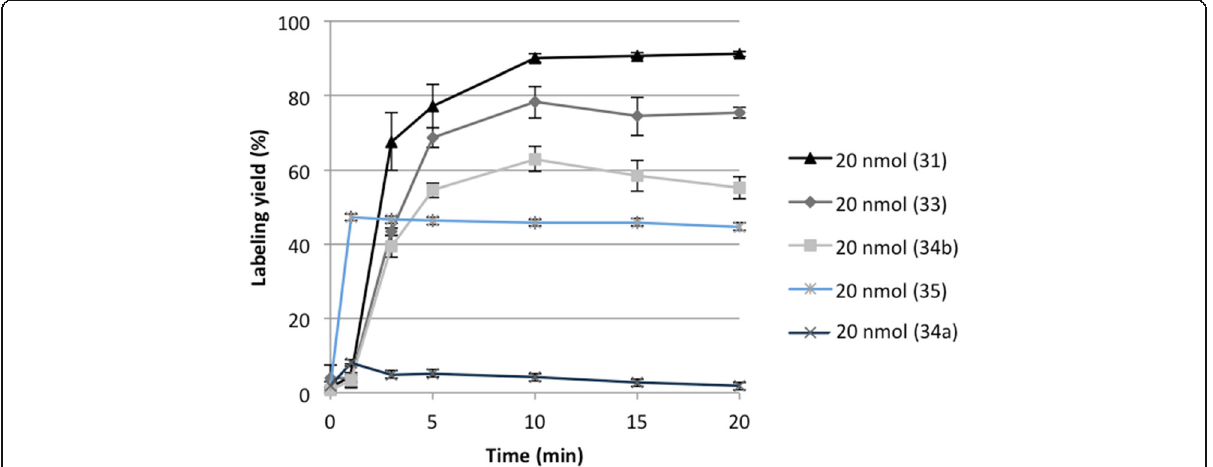
Fig. 5 Labeling yield using acetone post-processed gallium-68 (20 nmol; 15 min; 95 °C; n = 3)